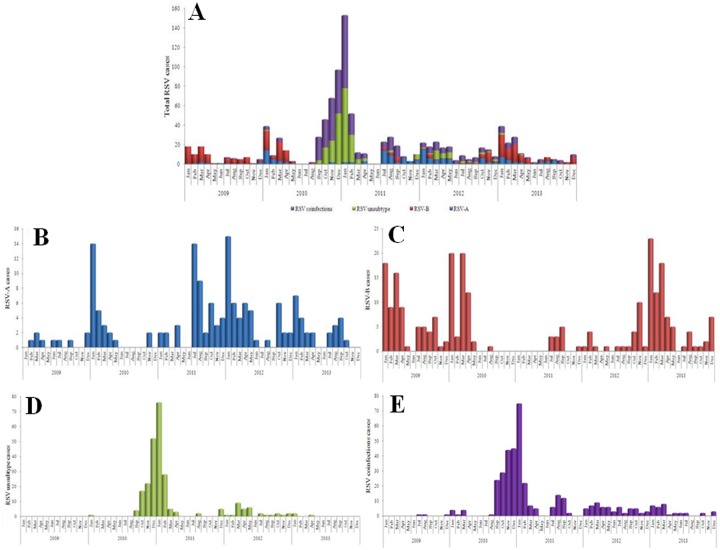
Seasonal trends of laboratory-confirmed RSV infection in hospitalized patients in eastern China between 2009 and 2013.(A) RSV infection; (B) RSV-A; (C) RSV-B; (D) Subtyping not performed; (E) Coinfection with other viruses.